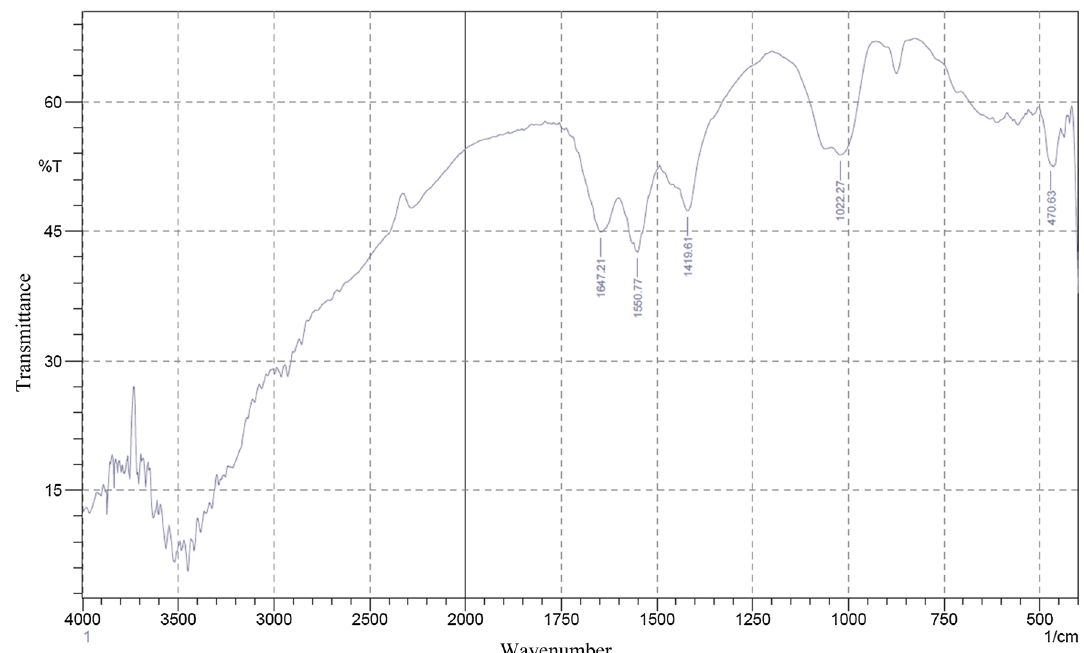
Fig. 9 SEM image of ion exchange membrane: a raw AEM membrane and b AEM facing anode chamber after treatment